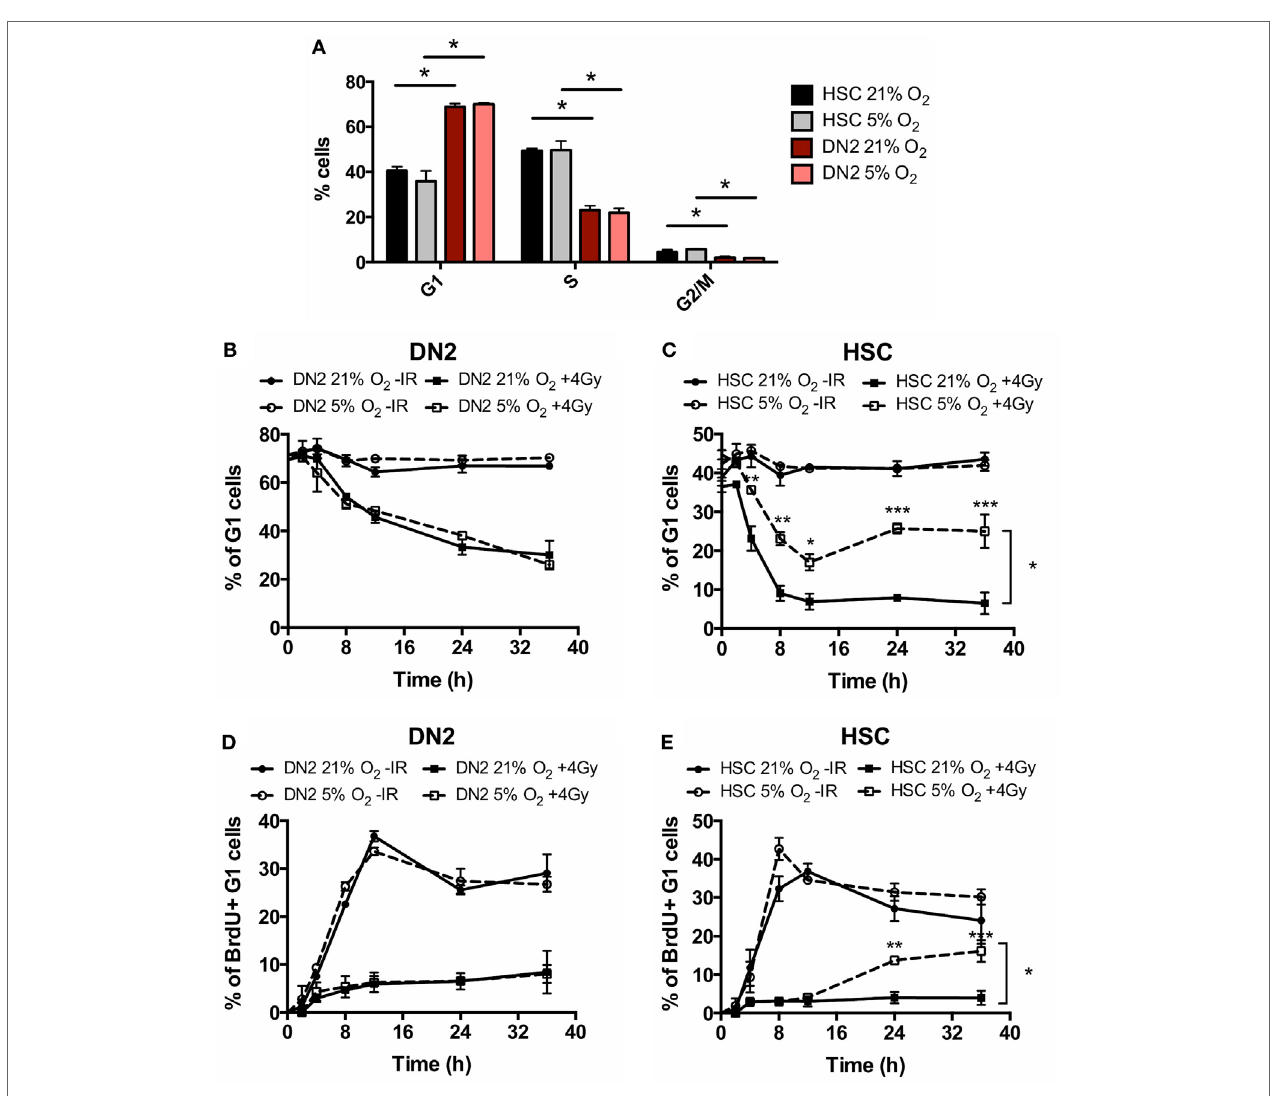
FigUre 4 | Cell cycle checkpoint activation of normoxic and hypoxic DN2 thymocytes. (a) Comparison of the percentage of cells in each phase of the cell cycle in NH-hematopoietic stem cell (HSC) and DN2 cells cultured in 21 or 5% O 2 . * p < 0.05, multiple t -tests with Holm–Sidak post-test correction. Quantification of average percentage of G 1 phase (B) DN2 and (c) NH-HSC cells cultured in either 21 or 5% O 2 , 0–36 h post bromo-deoxyuridine (BrdU) pulse, with or without treatment with 4 Gy of ionizing radiation (IR). * p < 0.05, ** p < 0.01, *** p < 0.001, two-way ANOVA analysis with Bonferroni post-test correction, n = 3. Quantification of average percentage of BrdU-labeled G 1 phase (D) DN2 and (e) NH-HSC cells cultured in either 21 or 5% O 2 , 0–36 h post BrdU pulse, with or without treatment with 4 Gy of IR. ** p < 0.01, *** p < 0.001, two-way ANOVA analysis with Bonferroni post-test correction, n =